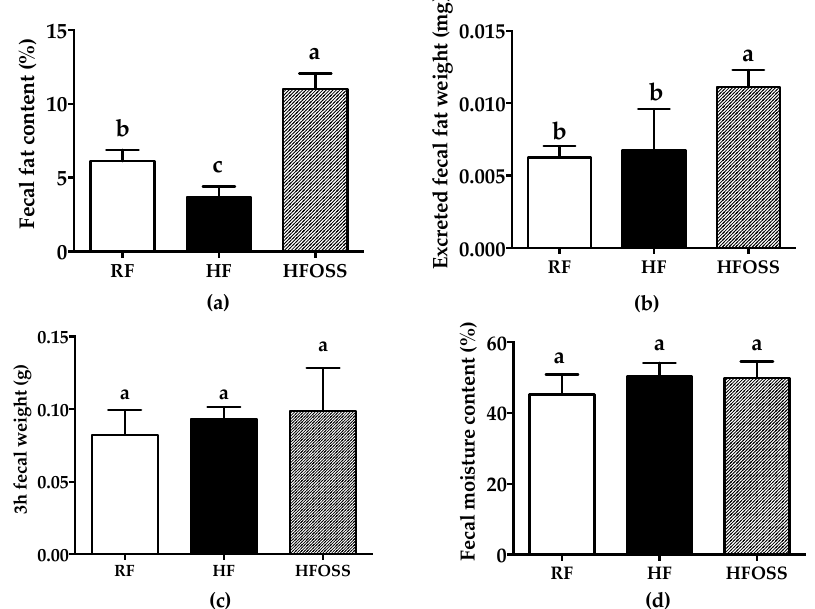
Figure 4. ( a ) Fecal fat content (weight%, based on the fecal weight as is); ( b ) excreted fecal fat weight per mouse during a 3 h collection period; ( c ) fecal weight of one mouse during a 3 h collection period; ( d ) fecal moisture content (%). Mice were fed a regular-fat diet (RF), high-fat diet (HF), and high-fat diet supplemented with OS starch (HFOSS). Values with different letters indicate significant differences between groups ( p < 0.05).